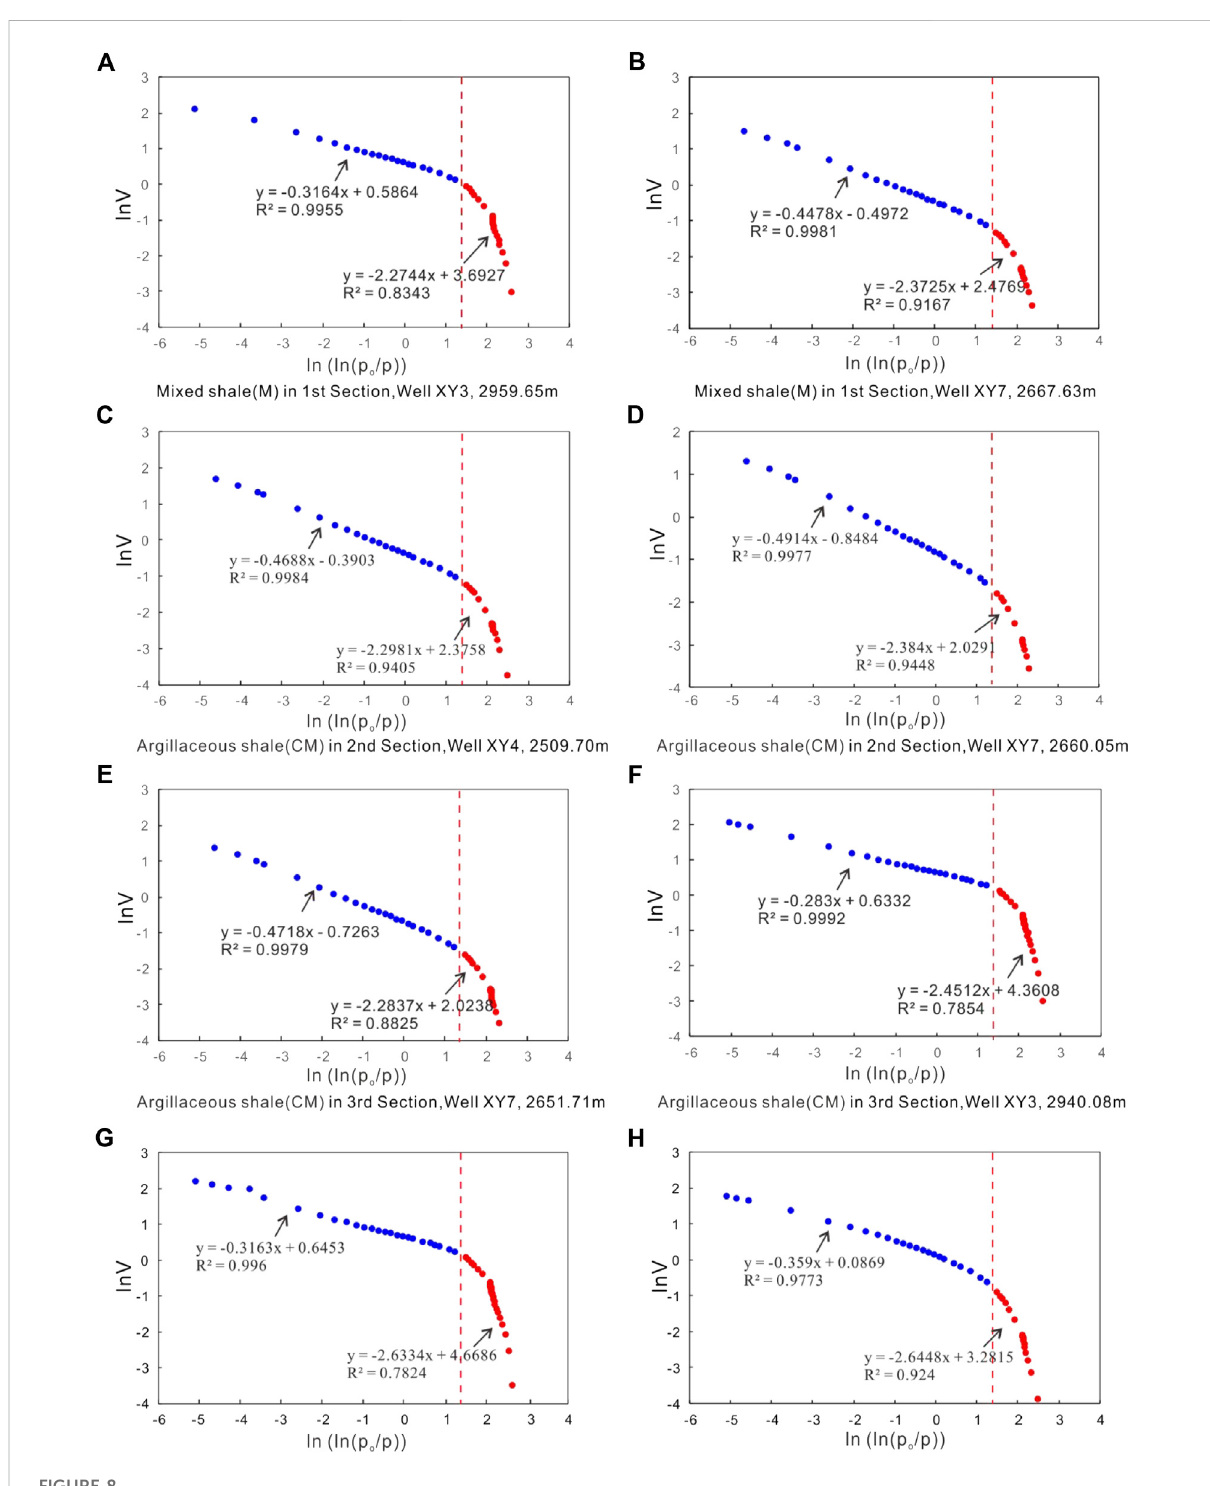
FIGURE 8 Schematicdiagram of fractal fi tting of shale samples with different lithofaciesfor the Jurassic Dongyuemiao lacustrine shale in Eastern Sichuan